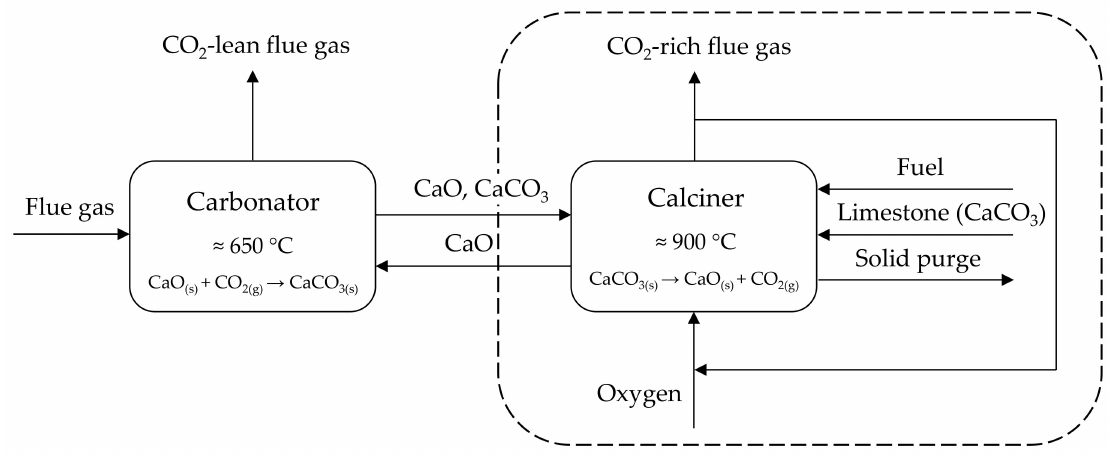
Figure 1. Schematic of the Calcium Looping process with the calciner enveloped in a dashed